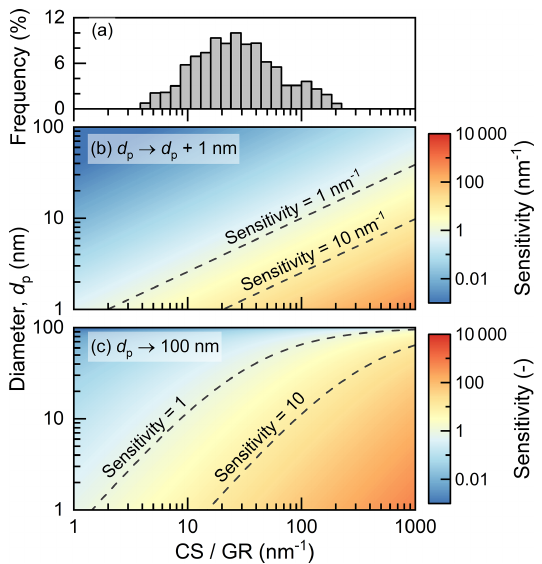
Figure 7. Sensitivity of the survival probability to the par- ticle growth rate (GR) and the coagulation sink. The size- dependent coagulation sink is characterized using the condensa- tion sink (CS) of the sulfuric acid. The sensitivity is defined as − dlog P theo / d(CS/GR), and it characterizes the relative change in survival probability per relative change in CS/GR. OM is short for order of magnitude. For instance, sensitivity = 1 indicates that a 100% relative change in CS/GR will result in a 1 order of mag- nitude change in the survival probability. (a) The frequency distri- bution of CS/GR in the measured NPF events in urban Beijing, with the frequency indicated by the height of each bar. (b) The sensitivity of the survival probability of particles growing by 1nm. (c) The sen- sitivity of the survival probability of particles growing to